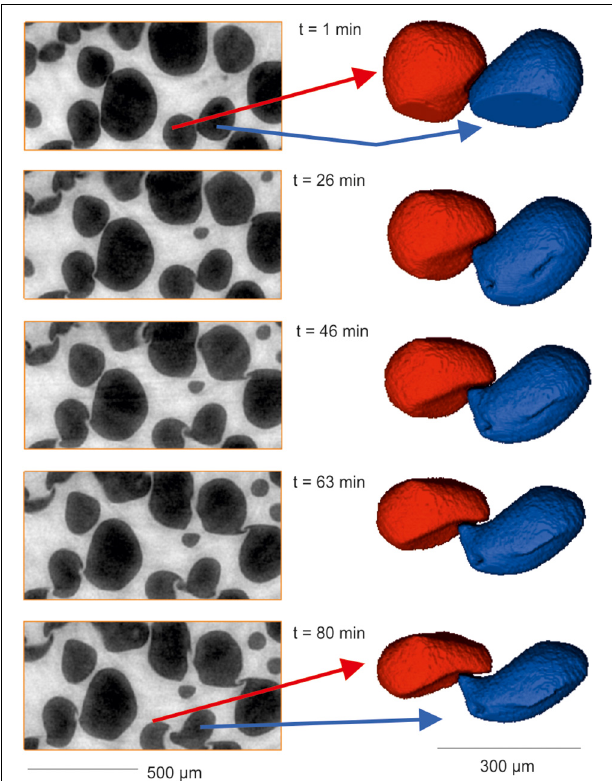
FIGURE 8 | Tracking bubble interactions during foam collapse. The panels on the left show a 2D axial slice through a sub-volume of the 4D data set at five time points during the experiment. The 3D renderings on the right show the changing interaction and complex “handshake” between two typical bubbles. Note the comparable near symmetric deformation of both bubbles around the interface. Most bubbles in the sample show some degree of dimpling at multiple bubble-bubbler interfaces, although some do have truly planar films. No thinning of the dimpled films is seen during this experiment, and no coalescence is observed despite the volume reduction in the